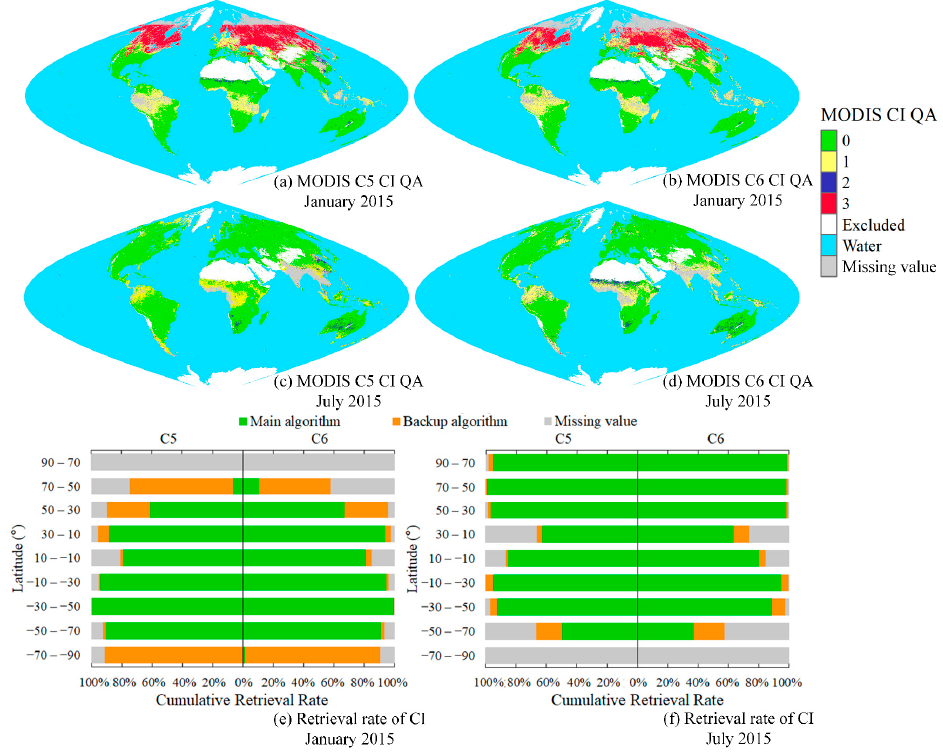
Figure 4. Global distribution of CI quality assurance (QA) data of the MODIS C5 and C6 CI products in January and July 2015. Panels ( a – d ) are global maps of the CI quality flags corresponding to the CI maps in Figure 2 (see Section 3.1.2 for more details). Panels ( e , f ) show the latitudinal distribution of the retrieval rates of different algorithm paths in January ( e ) and July ( f ) 2015. Possible algorithm paths include the main algorithm (green), backup algorithm (red), and missing value (not retrieved, gray). These statistics exclude non-vegetation areas (15-Snow and Ice, 16-Barren) according to the MODIS IGBP land cover